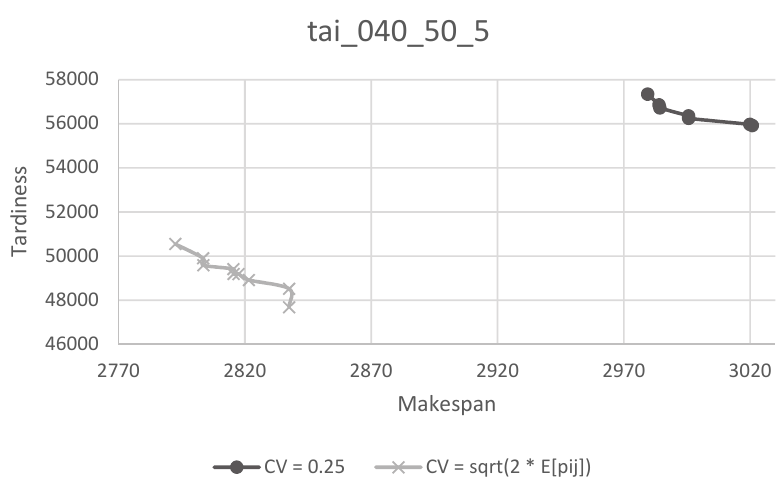
Fig. 7. Pareto fronts of Taillard’s instance 40 (50 jobs × 5